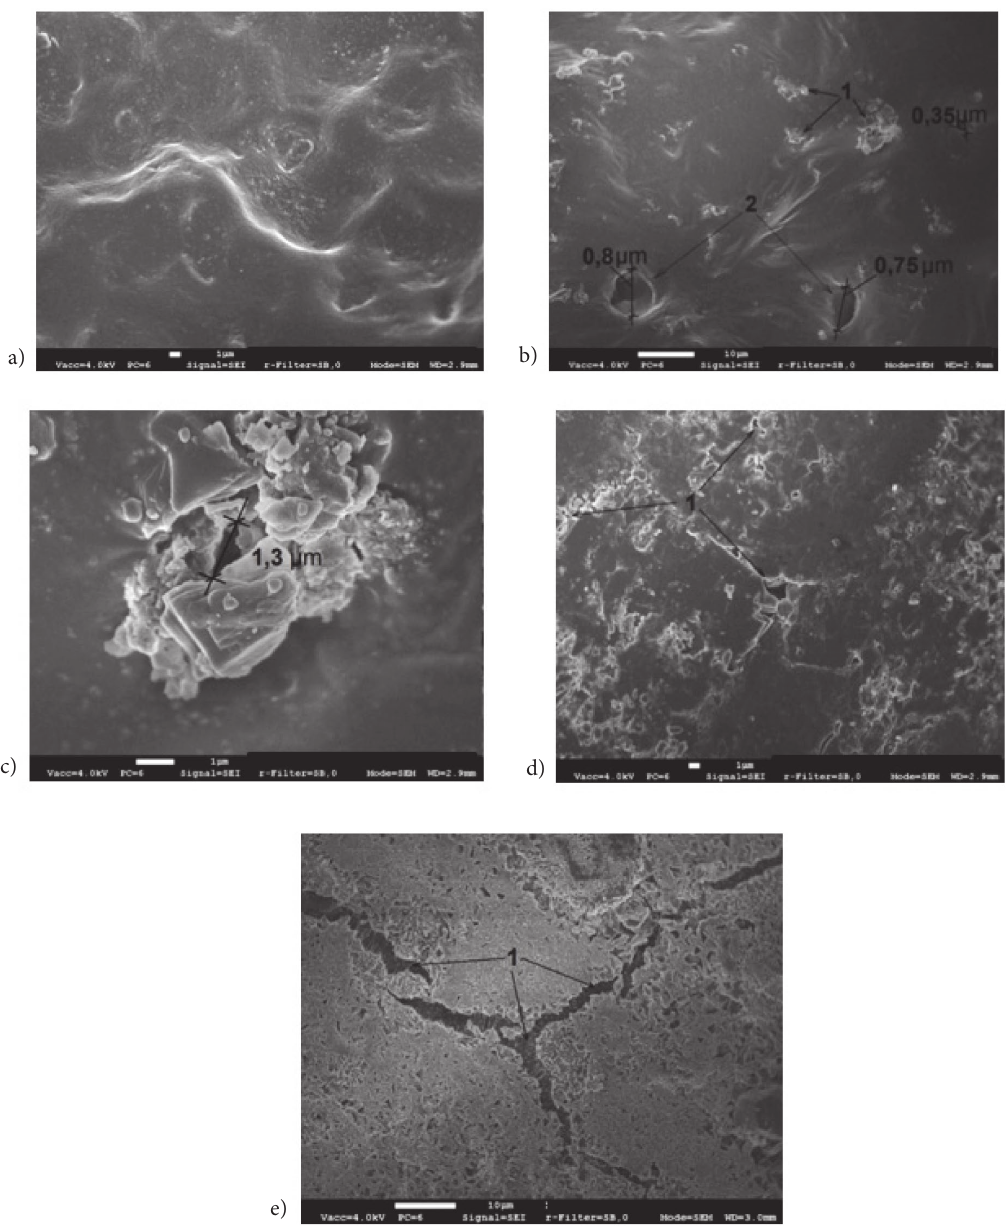
Figure 2. Images of microstructure of samples with STG50 paint coating: a – dry paint coating surface; b – paint coating surface after 12 months of natural aging: 1 – precipitate, 2 – cavity; c – paint coating surface after 12 months of natural aging, cavity formed in and around the precipitate; d – paint +ADD coating surface after 12 months of natural aging: 1 – cracks, delamination; e – paint + SDD coating surface after 12 months of